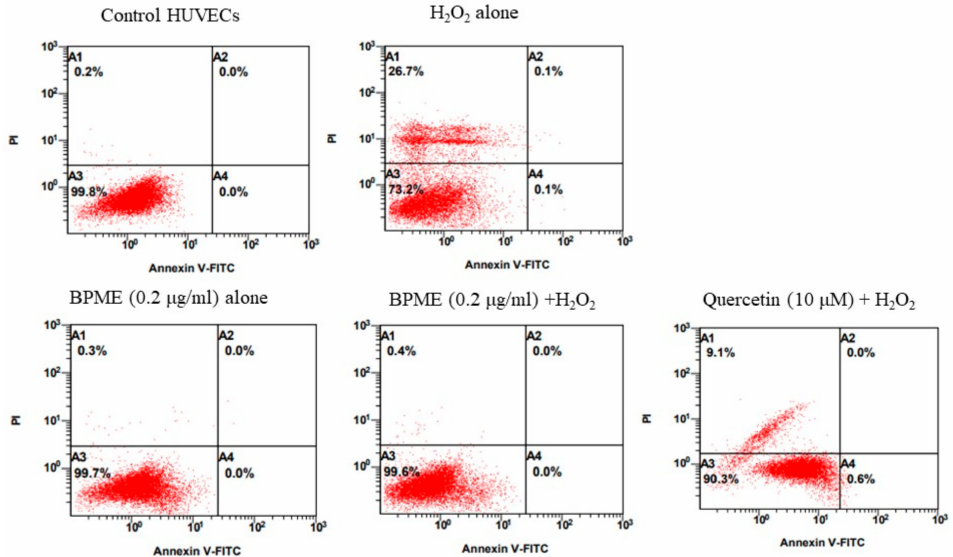
Figure 7. Annexin-V/propidium iodide double staining-based apoptosis, necrosis or late apoptotic characteristic analysis of BPME (0.2 µ g/mL)-treated normal and H 2 O 2 -induced oxidative-stressed HUVECs. Untreated cells were considered a negative control, whereas H 2 O 2 (10 mM) was added for positive control. (Annexin-V/apoptosis quadrants: A3: viable cells; A4: early apoptosis; A2: late apoptosis; A1: